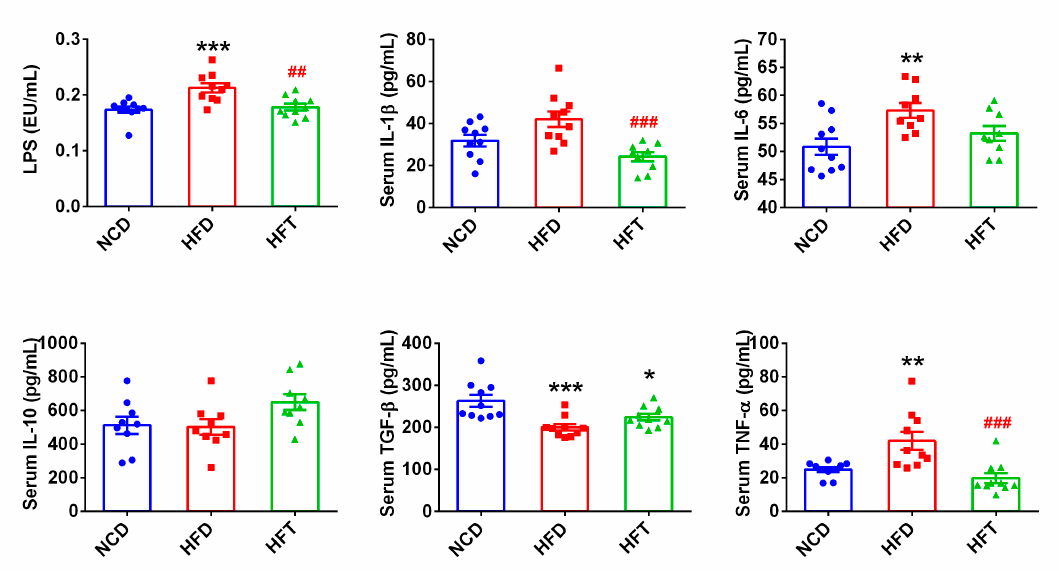
Figure 4. T17 administration significantly attenuated increased the circulating level of LPS and pro-inflammatory cytokines induced by HFD. Data are expressed as mean ± SEM. Values marked with * are significantly different compared with NCD group and values marked with # are significantly different compared with HFD group (* p < 0.05, ** or ## p < 0.01, *** or ### p < 0.001).